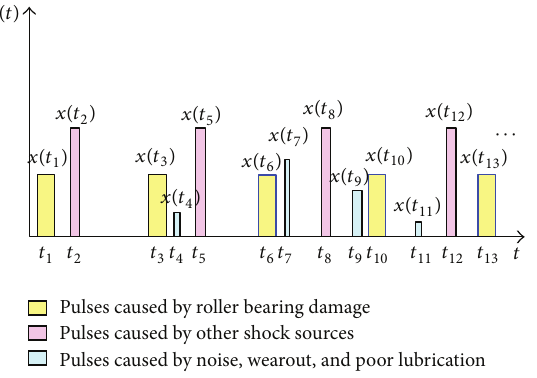
Figure 5: Schematic diagram of shock pulse ordering.